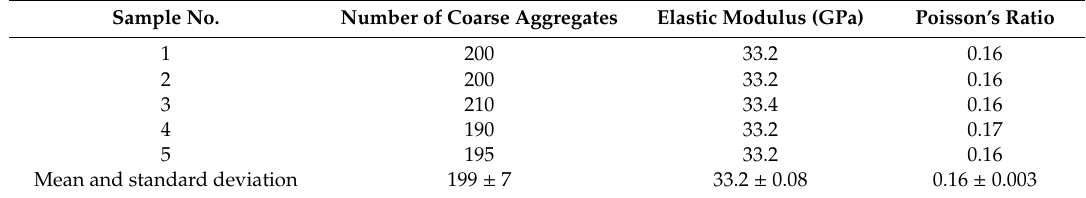
Table 7. A summary of aggregate parameters and calculated elastic constants of samples generated with gradation requirements fulfilled.